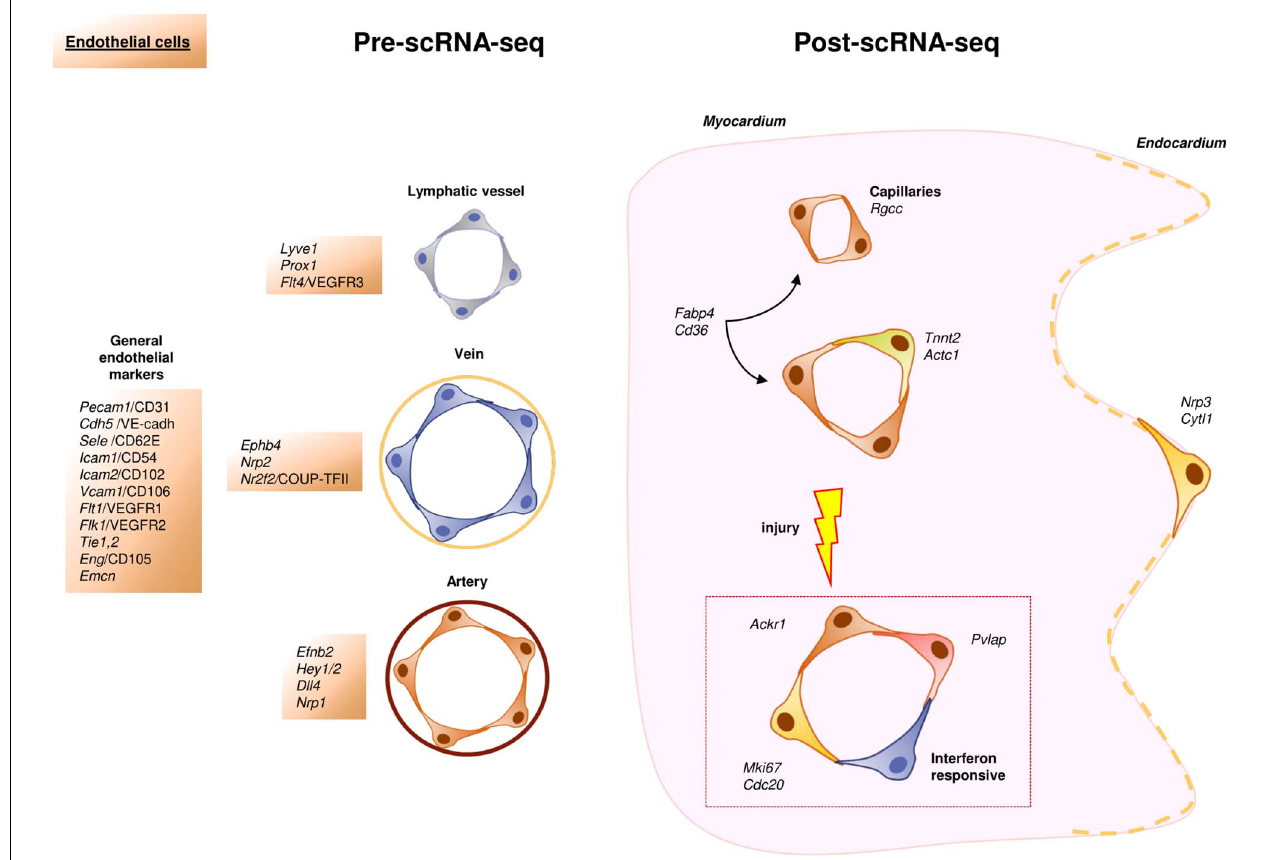
FIGURE 2 | Schematic representation of the cardiac endothelial cellular landscape before and after scRNA-Seq. In the scRNA-Seq part, each color represents an identified cell subpopulation characterized by specific genes, cellular functions or other relevant